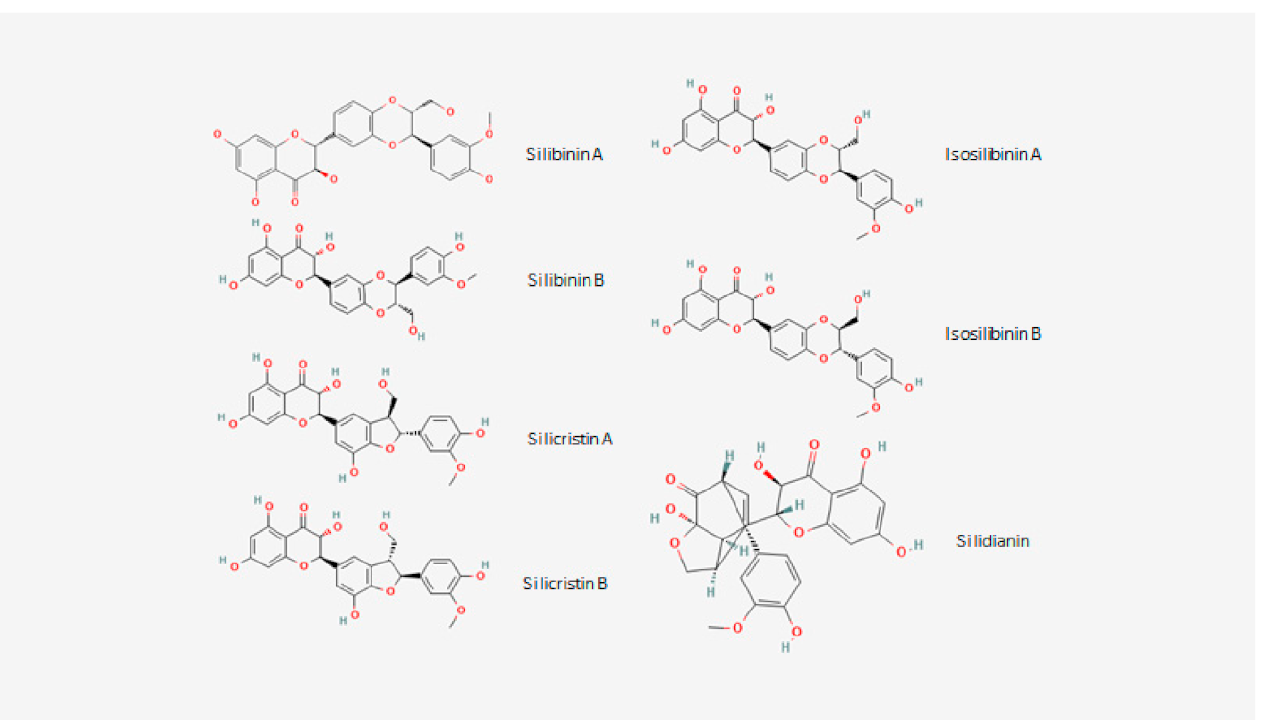
Figure 2. Chemical structures of the main ingredients (flavonoglicans) of Silymarin extract. Silibinin’s structure has 5 hydroxyl groups which are the primary targets of the derivatization process. Three of these hydroxyl groups (5-OH, 7-OH, and 20-OH) possess